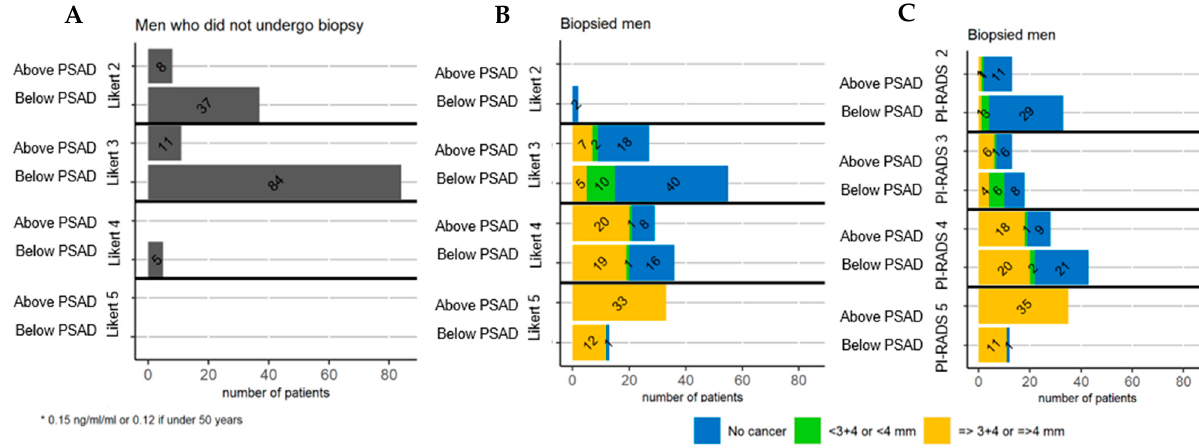
Figure 1. Men within the INNOVATE cohort were separated into those who did ( B ) and did not ( A ) undergo prostate biopsy after mpMRI. Within these two groups men are subdivided into 8 groups shown as bars on the Y-Axis. Groups are defined by the highest scoring lesion on mpMRI (Likert score 2, 3, 4 or 5) and if their PSA Density (PSAD) was below or above a threshold of 0.15 ng/mL/mL or 0.12 for men under 50 years old. The bar size reflects the number of men in each group, numbers are shown as text overlaying each bar. Men who did not undergo biopsy as colored Grey. When patients underwent prostate biopsy, the bars are further subdivided into 3 groups depending on the resulting overall pathology of their biopsy (Blue = No cancer of any grade, Green = clinically non-significant cancer, Yellow = clinically significant prostate cancer.). The final graph on the far right ( C ) represents the same men as detailed in ( B ) however in this graph they are grouped by the highest scoring lesion on mpMRI re-scored as PI-RADSv2. (score 2, 3, 4 or 5). Table 2. For the men who underwent biopsy the mpMRI lesion that scored highest was re-scored with PI-RADS retrospectively. Proportion of patients with equivalent or a different PI-RADS score stratified by Likert score and having a PSAD above or below a threshold of 0.15 (or 0.12 for men aged <50). PI-RADS was not used to select patients for biopsy. Pre-biopsy